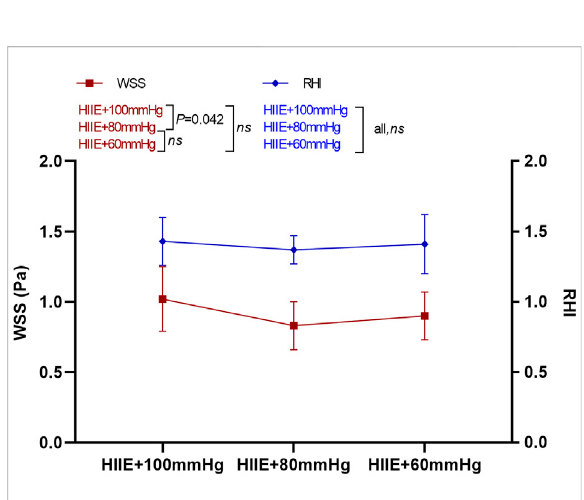
FIGURE 3 Changes in RHI and WSS after HIIE intervention with different in fl ations. Note: RHI, reactive hyperemia index; WSS, wall shear